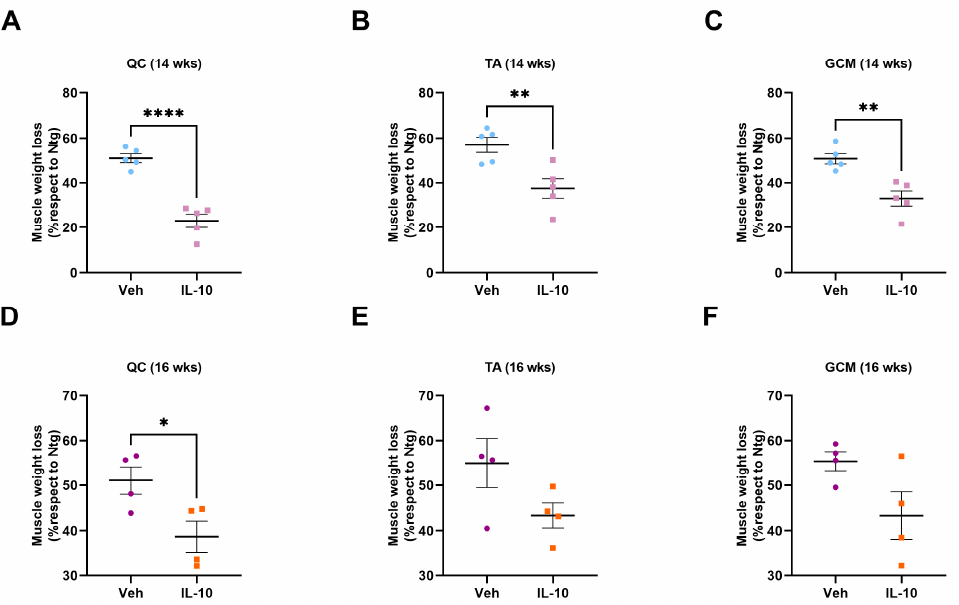
Figure 2. Intramuscular IL-10 administration delays muscle atrophy in C57-SOD1G93A mice. ( A–F ) Muscle wasting was calculated at 14 and 16 weeks of age by measuring the quadriceps (QC) ( A , D ), tibialis anterior (TA) ( B , E ), and gastrocnemius Medialis (GCM) ( C , F ) muscle weight of IL-10- and PBS-treated C57-SOD1G93A mice compared to Ntg littermates. The data are presented as th emean ± SEM. The independent experiments are scattered on the graph at each time point for each experimental group. * p < 0.05, ** p < 0.01, **** p < 0.0001 by unpaired t -test.